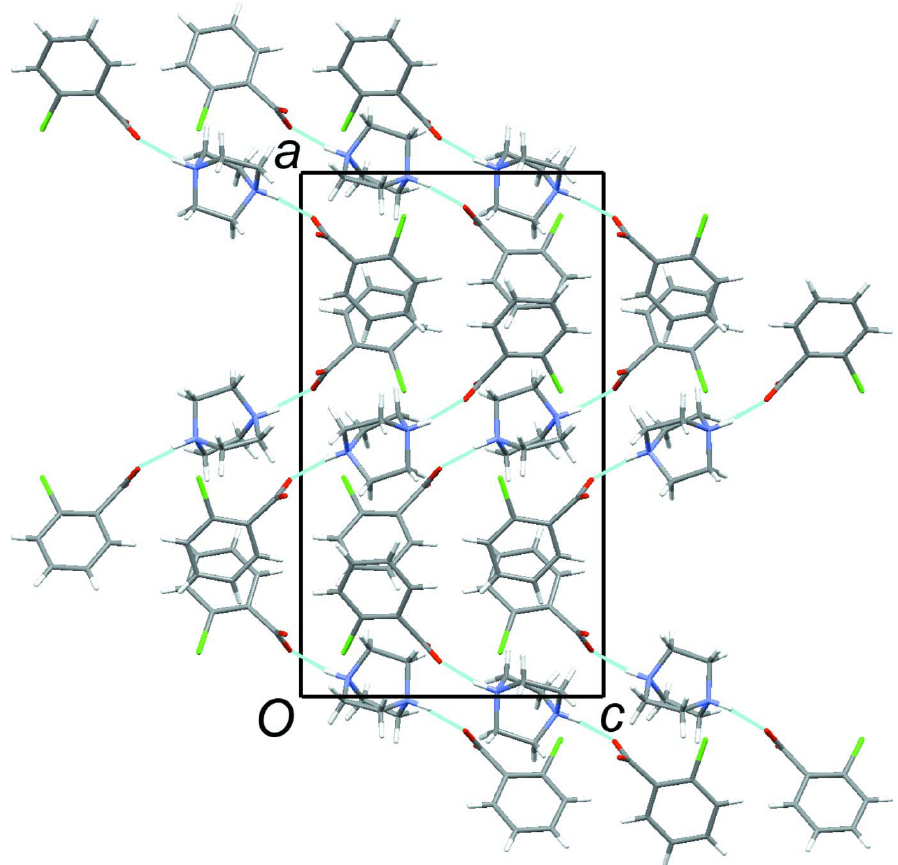
Figure 2 View along the c axis, showing the layered arrangement of hydrogen-bonded trimers. The light blue lines denote N + — H···O - hydrogen